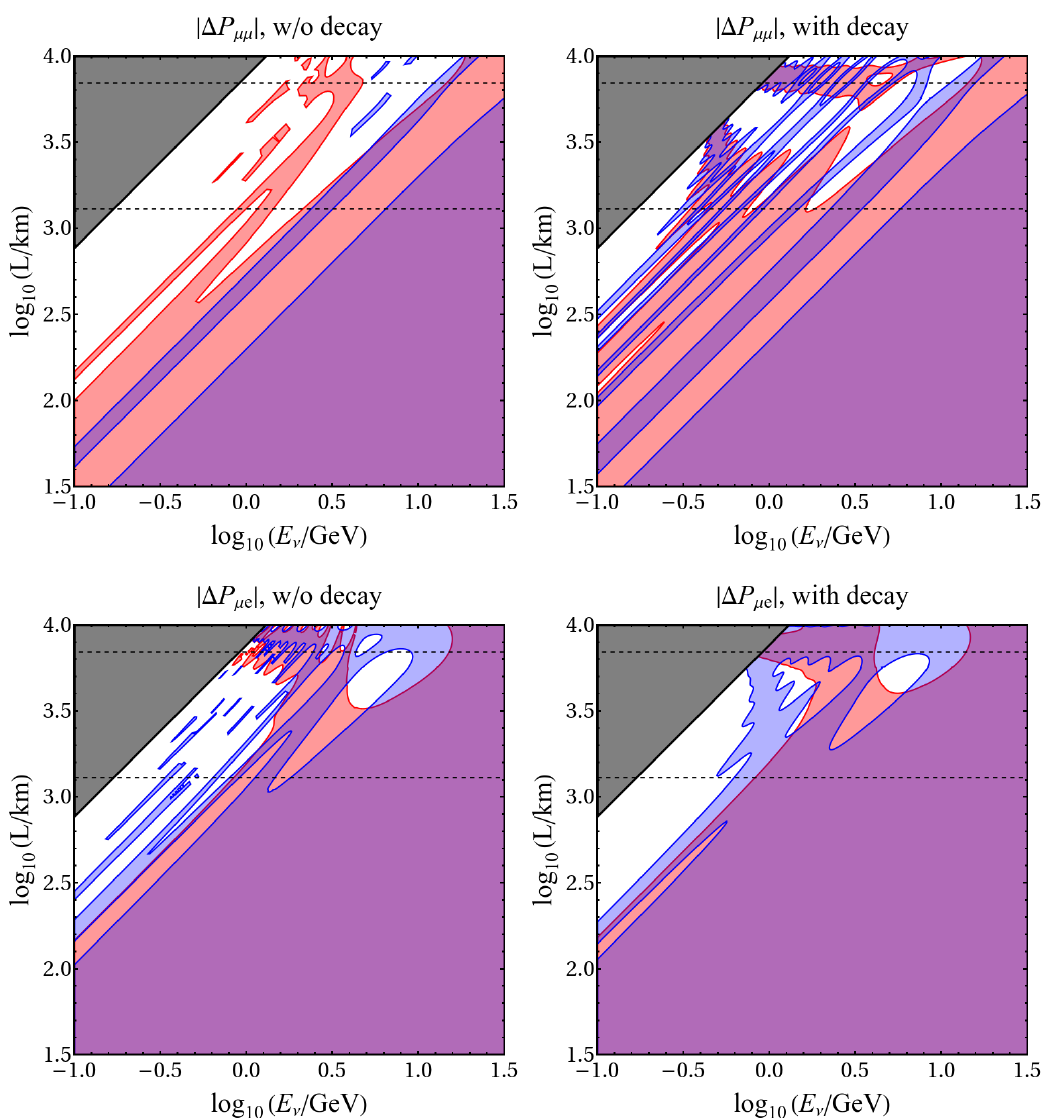
Figure 5 . The regions in the ( E ν , L ) parameter space where | ∆ P αβ | < 1% with the OMSD approximation (blue) and the Expansion method (red). The top two panels correspond to | ∆ P µµ | and the bottom two panels correspond to | ∆ P . The purple region satisfies this criteria for both µe | methods. In the gray region, our analytic approximations are not valid, since α ∆ > 1 . The white spaces indicate where the analytic approximations are valid but not accurate up to 1%. The small isolated colored patches in the white regions (“islands”) are where the analytic and numerical results match by coincidence. The horizontal dashed lines indicate the baselines L = 1300 km and L = 7000